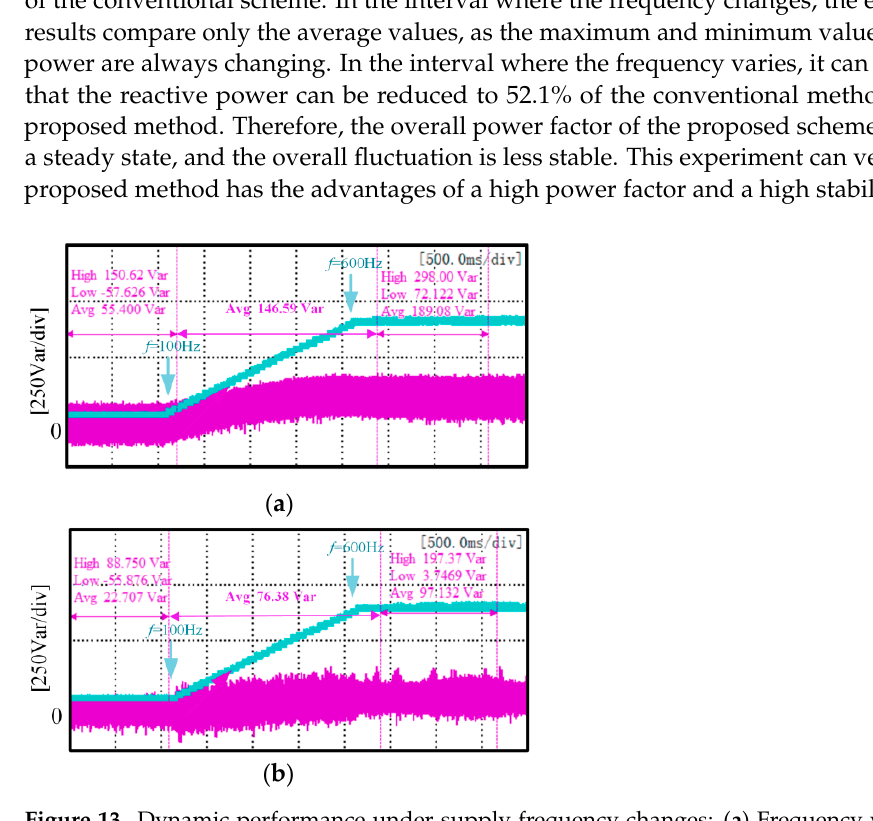
( d ) Figure 12. Comparison of three-phase current waveforms and THD: ( a ) the three-phase current waveform of the conventional deadbeat direct power control; ( b ) the three-phase current waveform of the proposed scheme; ( c ) THD of conventional deadbeat direct power control current; ( d ) THD of proposed scheme current. Figure 13 shows the DC side voltage and reactive power change waveform when the frequency rises in a ramp form. To further simulate the operation of the actual working